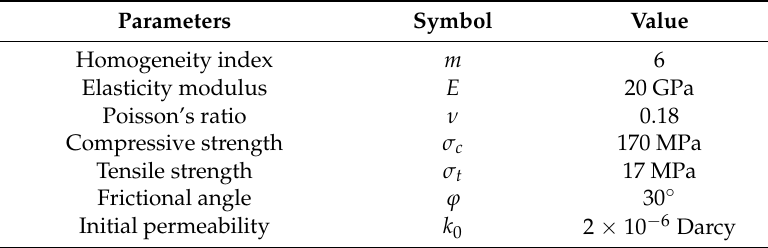
Table 3. Material Table 3. Material parameters.